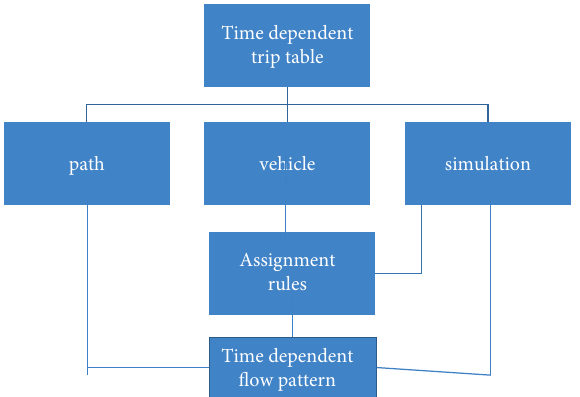
Figure 5: The simulation process revolves around a set of au- tonomous